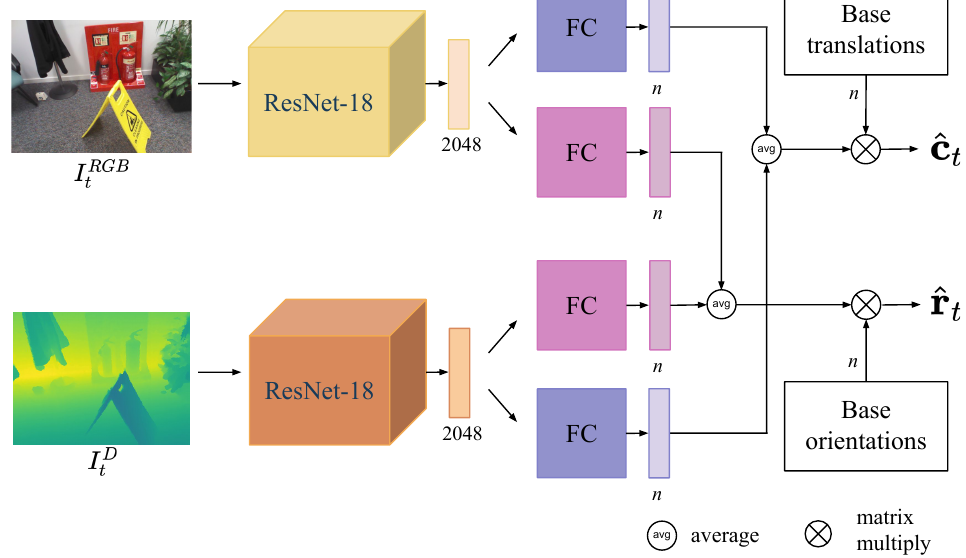
Figure 2. Network architecture of proposed method. Rectangles behind the ResNet-18 or FC layers represent their output vectors. Symbol n denotes the number of base poses as well as the output dimension of the FC